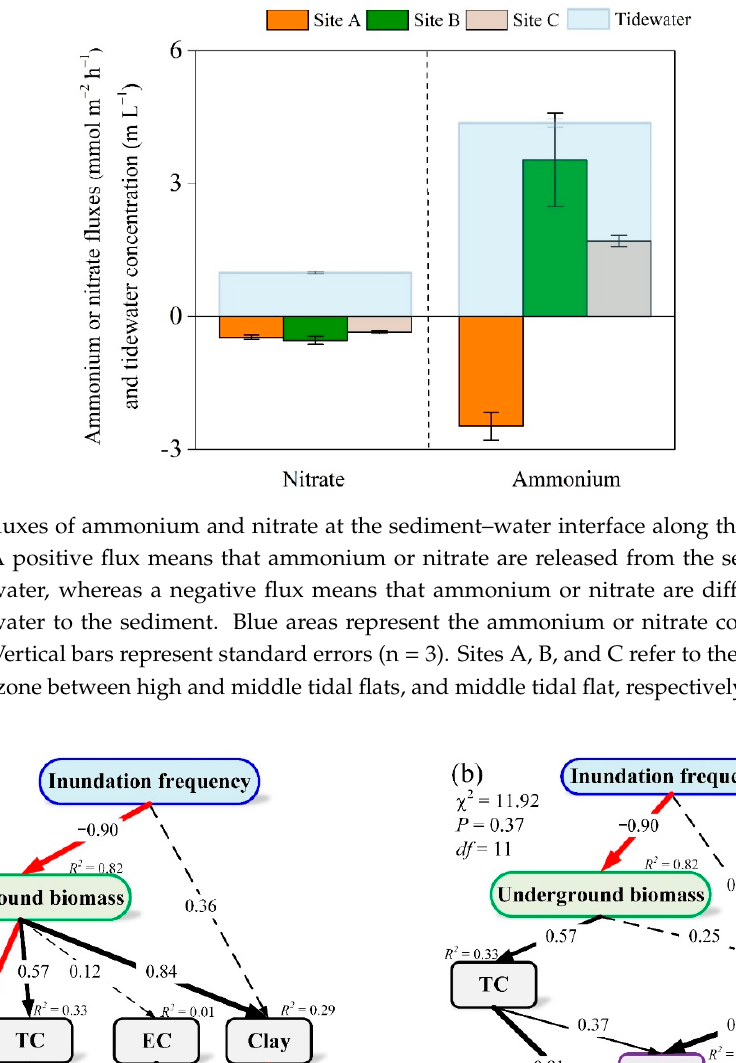
overlying water, whereas a negative flux means that ammonium or nitrate are diffused from the overlying water to the sediment. Blue areas represent the ammonium or nitrate concentration of tidewater. Vertical bars represent standard errors (n = 3). Sites A, B, and C refer to the high tidal flat, interaction zone between high and middle tidal flats, and middle tidal flat, respectively.